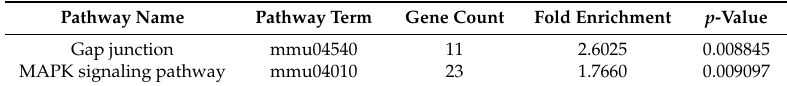
Table 5. KEGG pathway in LC group hypomethylated genes ( p < 0.01).